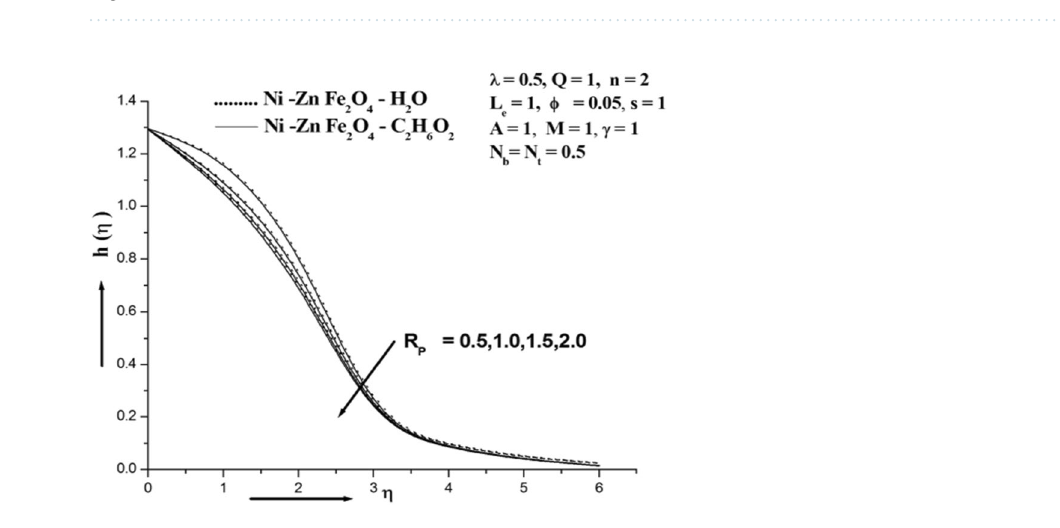
Figure 3. Illustration of concentration for various M.